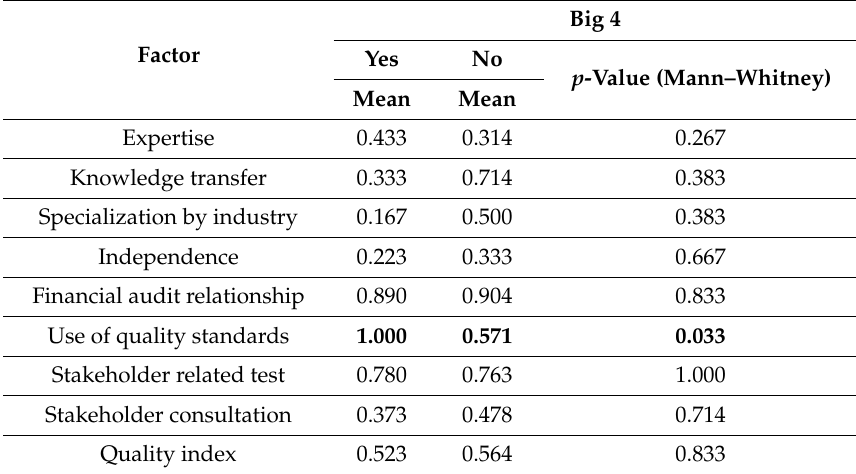
Table 12. Assurance quality vs. Big 4.